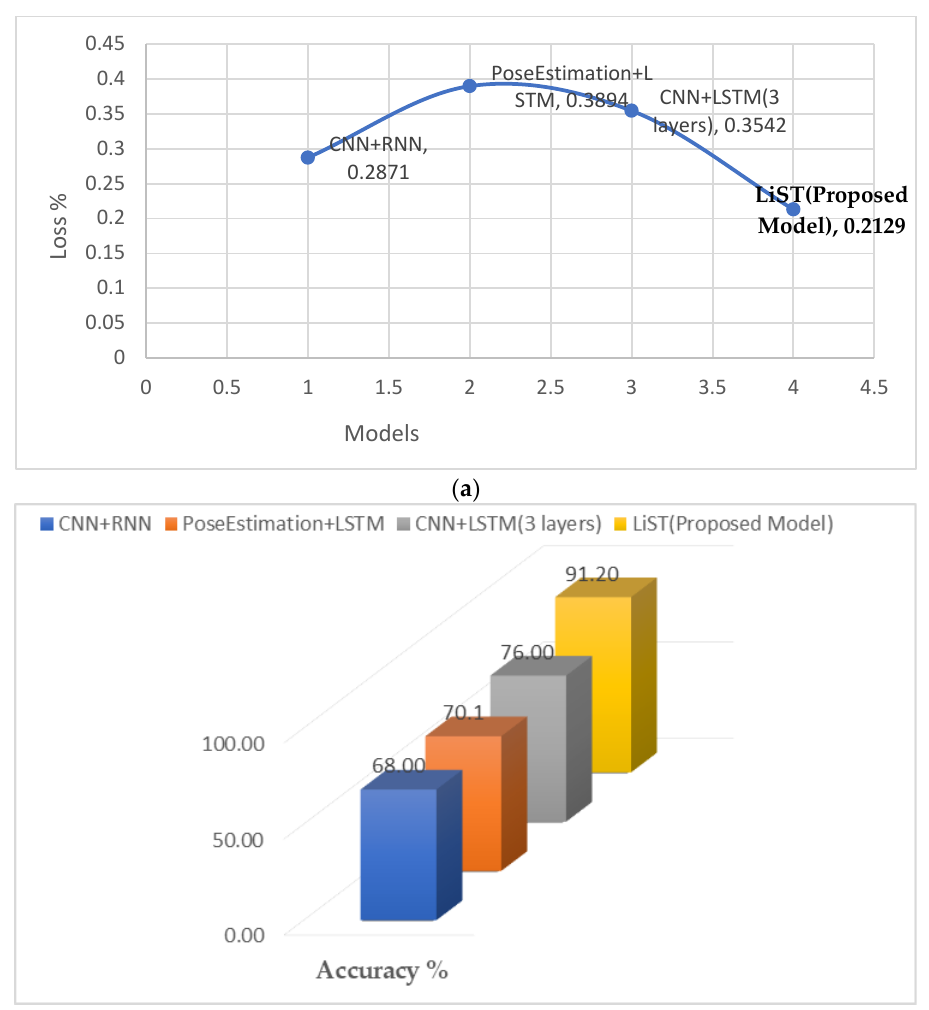
Figure 9. Performance comparison between LiST and existing models. ( a ) Loss function comparison; ( b ) accuracy comparison with other existing models.